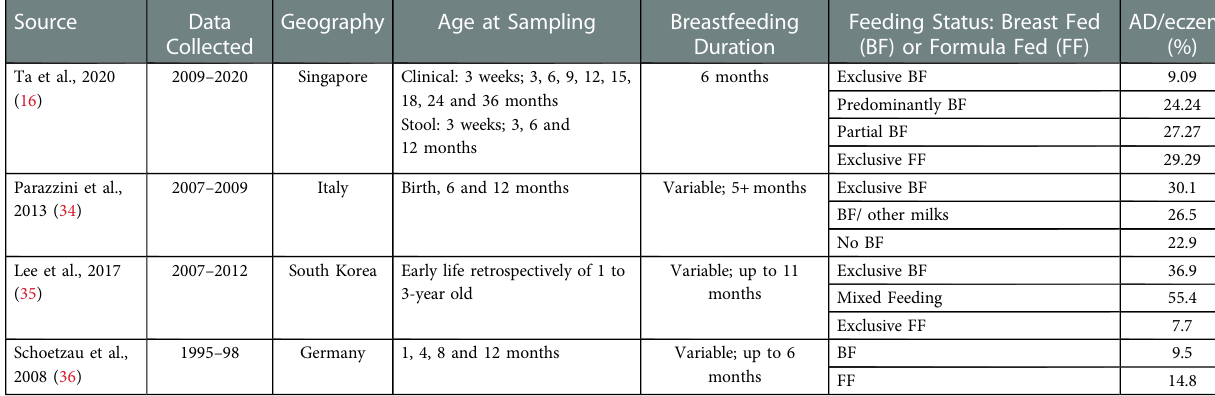
TABLE 1 Prevalence of AD/eczema in human milk or formula fed infants.